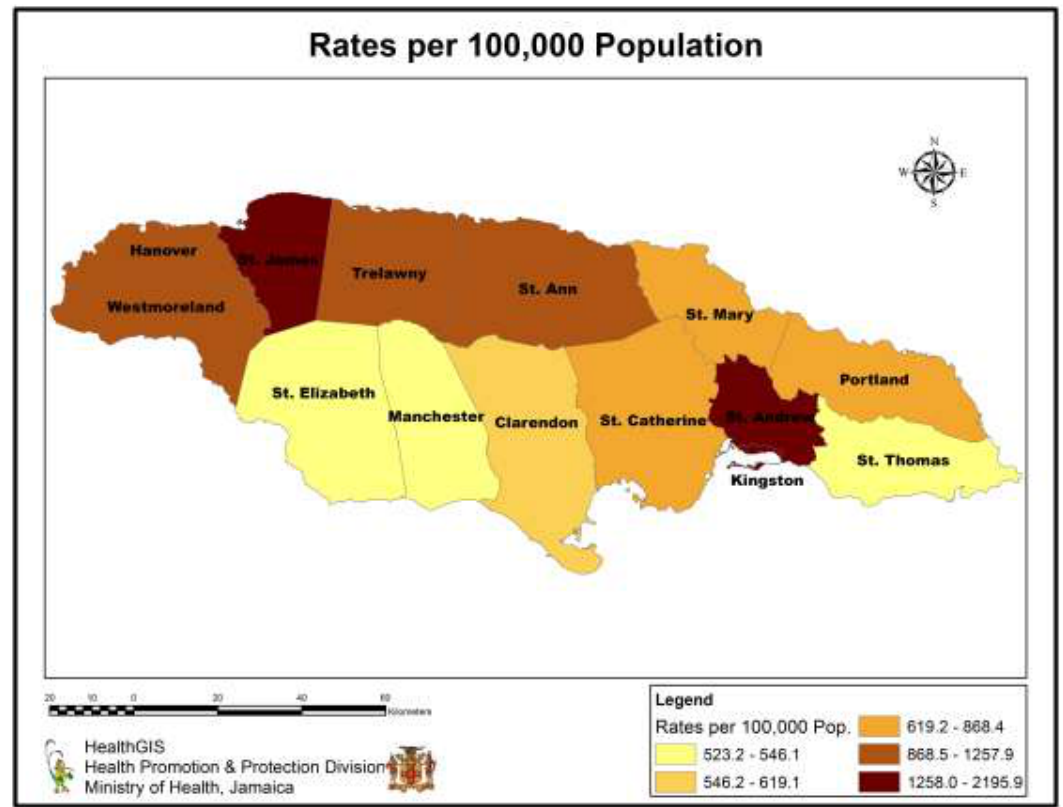
Figure 1. Cumulative reported HIV case rates per 100,000,